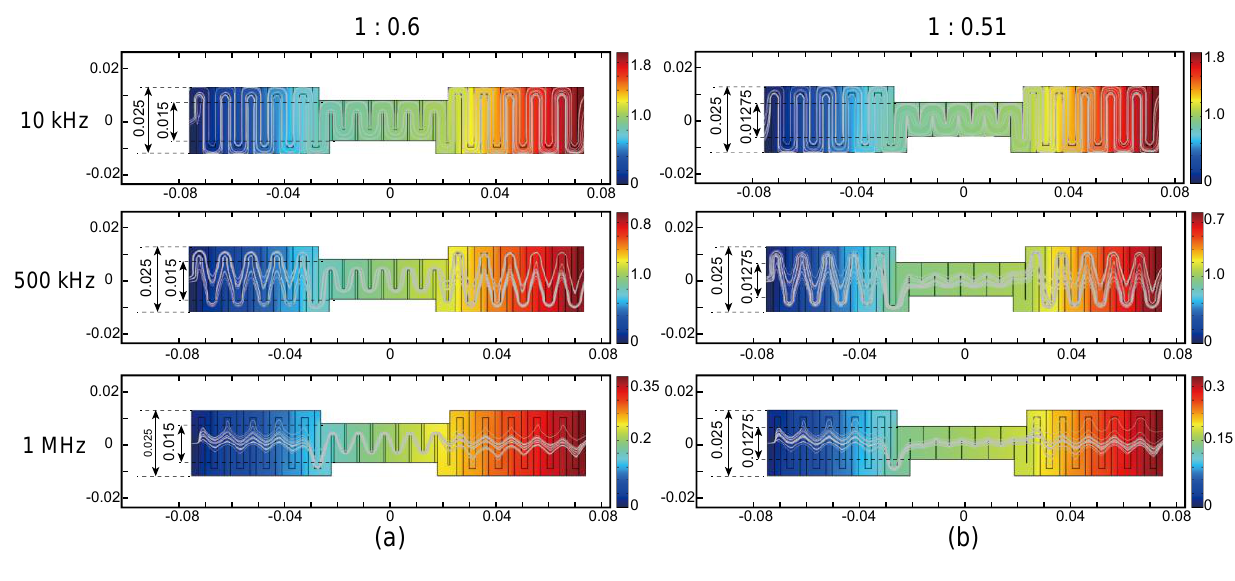
Figure 4. Computed electric potential distributions and current streamlines inside the fabric under two different amounts of compression. The color bars denote the electric potential subject to the injected current from the right to left direction. The curved lines are current streamlines. (a) and (b) show the electric potential distributions and current streamlines, respectively, at 10, 500, and 1000 kHz subject to two different amounts of compression (1:0.6 and